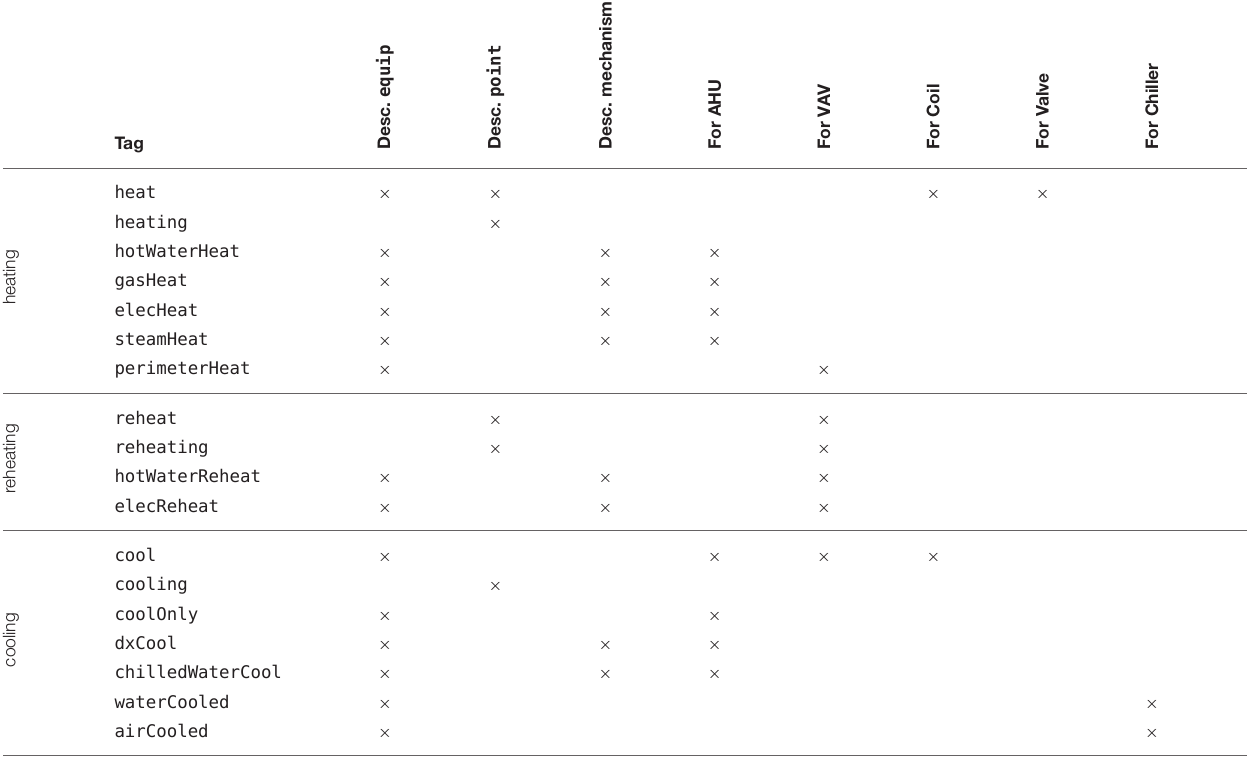
TABLE 1 | An enumeration of the intended use and context of tags relating to heating and cooling, as given by the Haystack documentation.